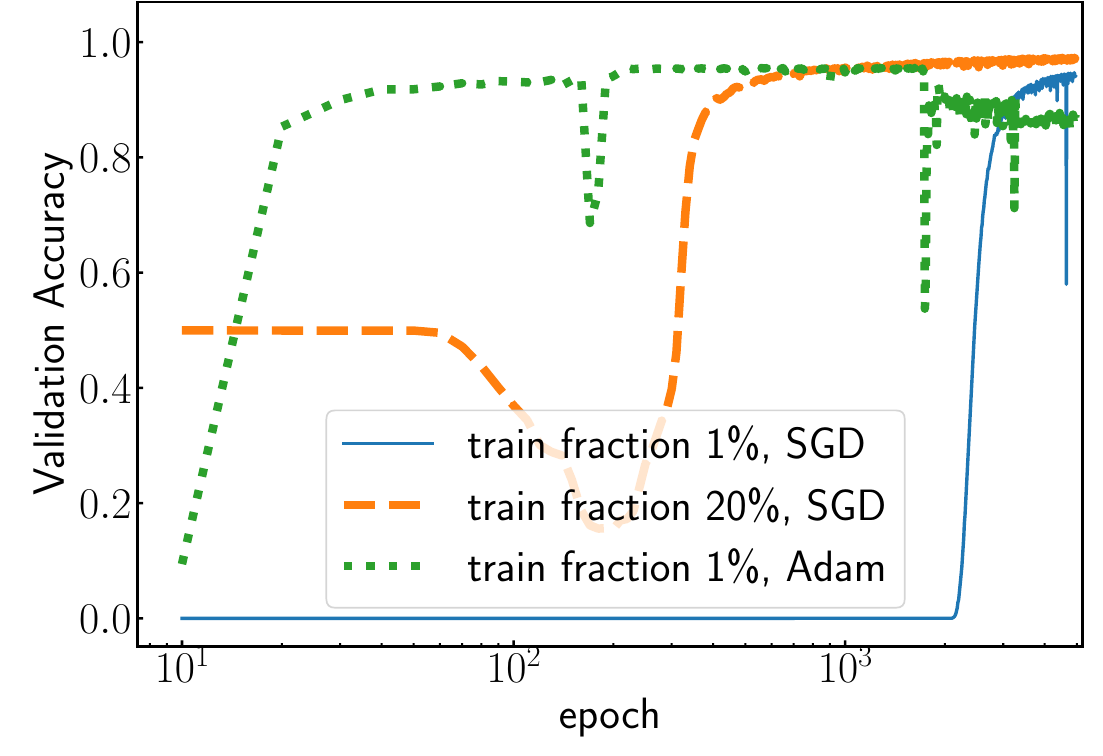
Figure 8 . The same as (cid:12)gure 6 but for central Au+Au collisions at p s = 14 GeV. with a combined EoS containing certain fraction x of the soft EoS and complementary fraction 1 x of the sti(cid:11) EoS. The model trained on such data would de(cid:12)nitely give us (cid:0) fractions of both EoS. It will take more time because of the amount of generated data and longer training procedure. But, as we show in our study, the application of sophisticated algorithms, like Adam, makes solving this problem